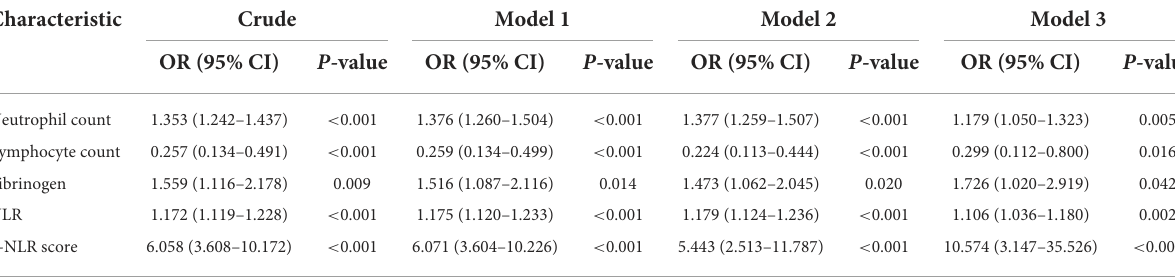
TABLE 2 Association of laboratory parameters with functional outcome at 3 months after aSAH.